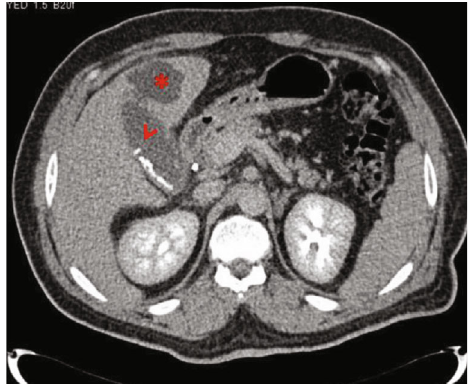
Figure 1: Abdominal CT scan showing gallbladder containing stones (arrow), with nearby segment IV b abscess